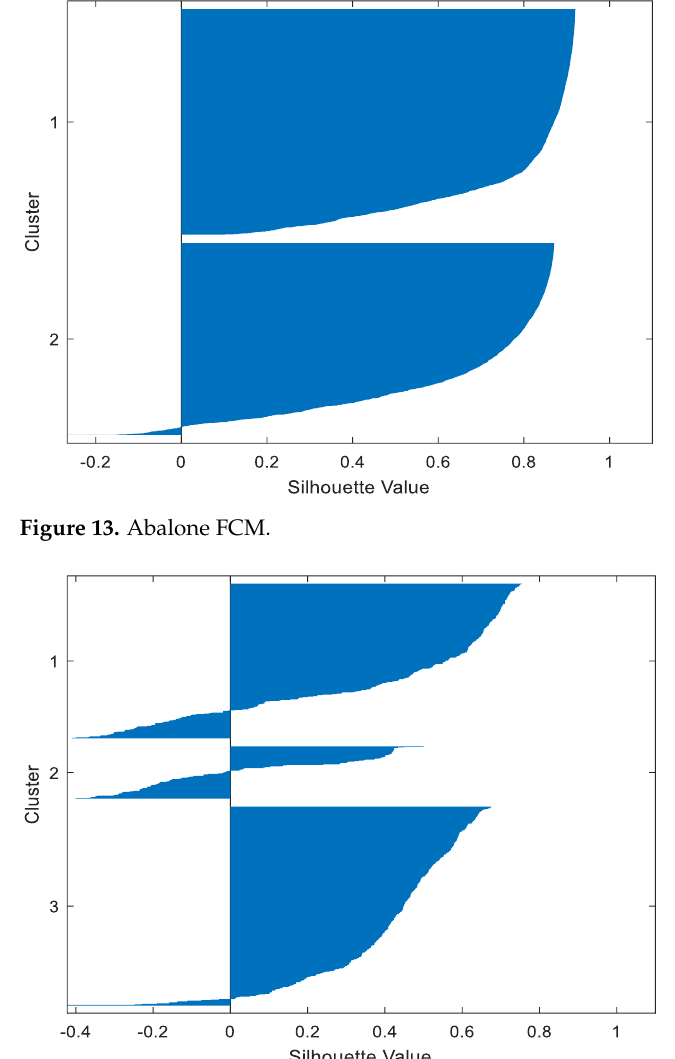
Figure 14. Abalone Figure 14. Abalone GMM. Figure 14. Abalone GMM.